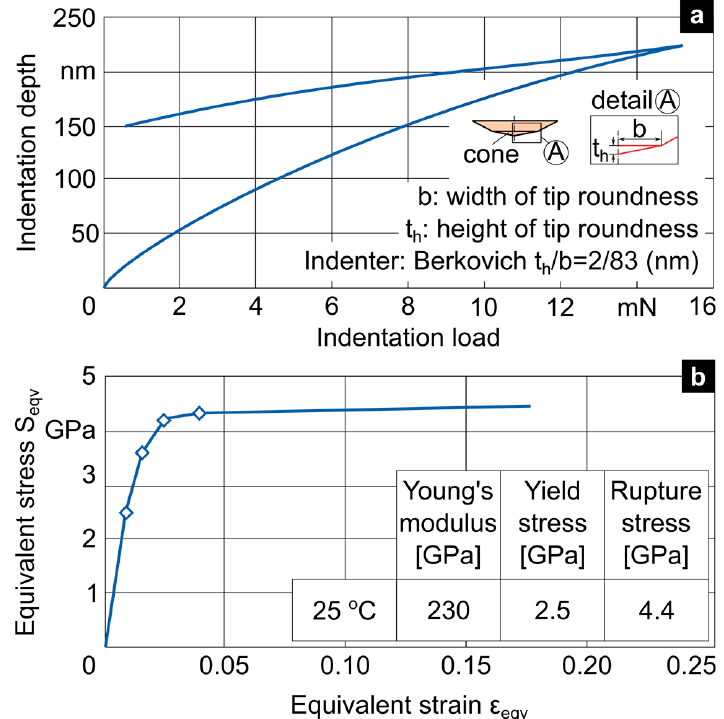
Figure 3. ( a ) Nanoindentation results on high-speed steel (HSS) at ambient temperature; ( b ) stress–strain curve of the HSS, attained via a finite element method (FEM)-supported evaluation of the nanoindentation results.